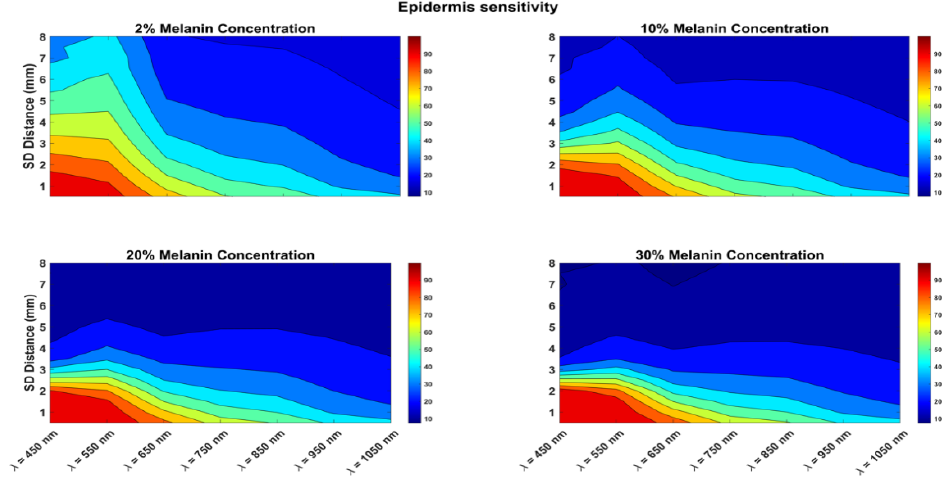
Figure 3. Epidermis sensitivity for various melanin concentrations and with the wavelength ranging between 450 and 1050 nm. Sensitivity also shown for SDS ranging from 0.5 to 8 mm.